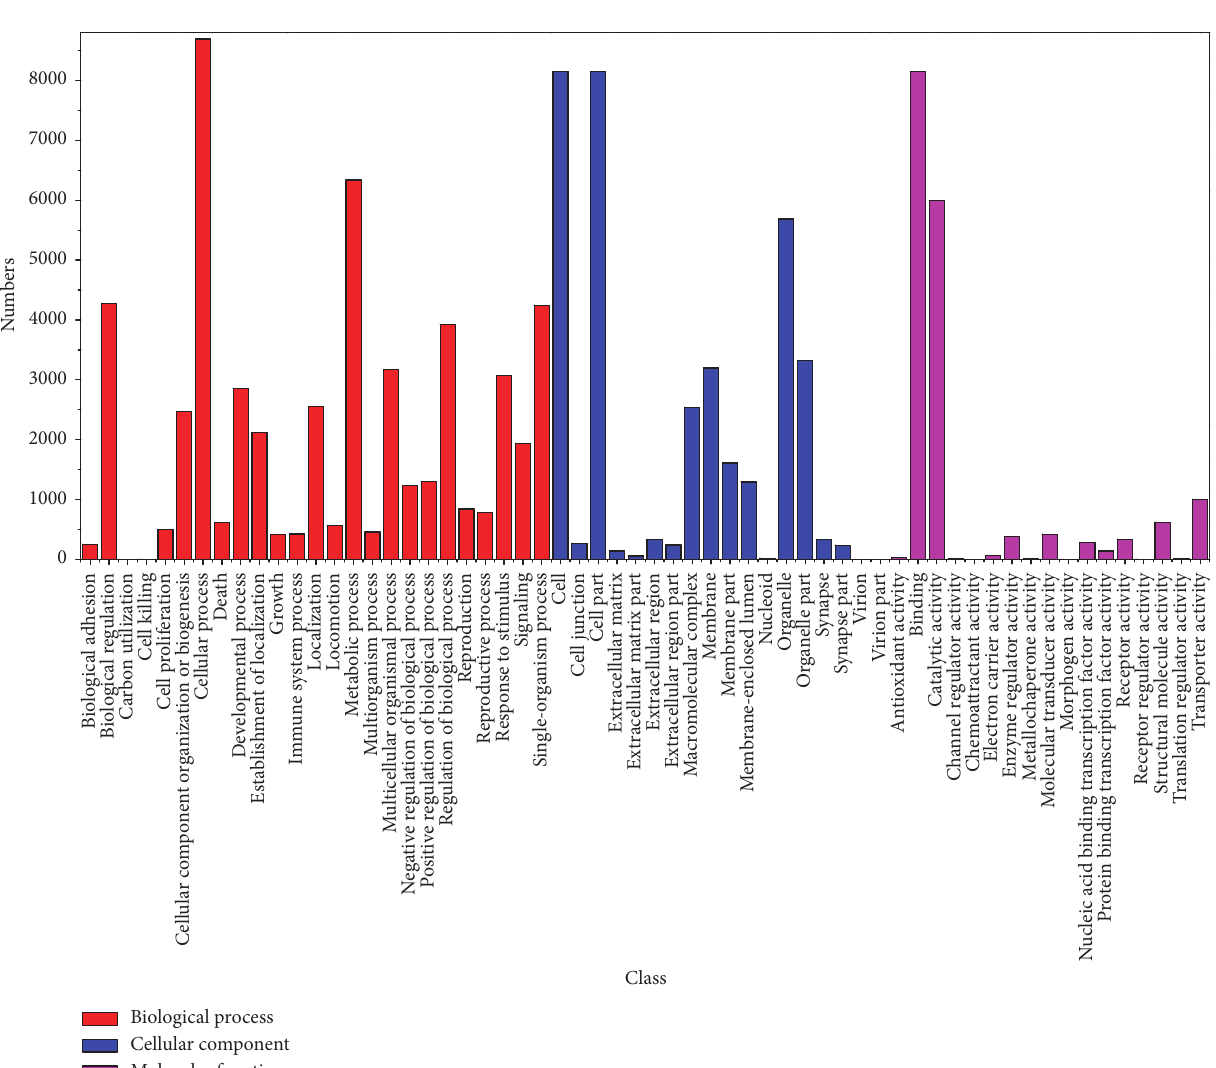
Figure 4: GO categories of unigenes. 13,465 of 174,126 unigenes were assigned to GO annotation and divided into three categories: biological processes, cellular components, and molecular